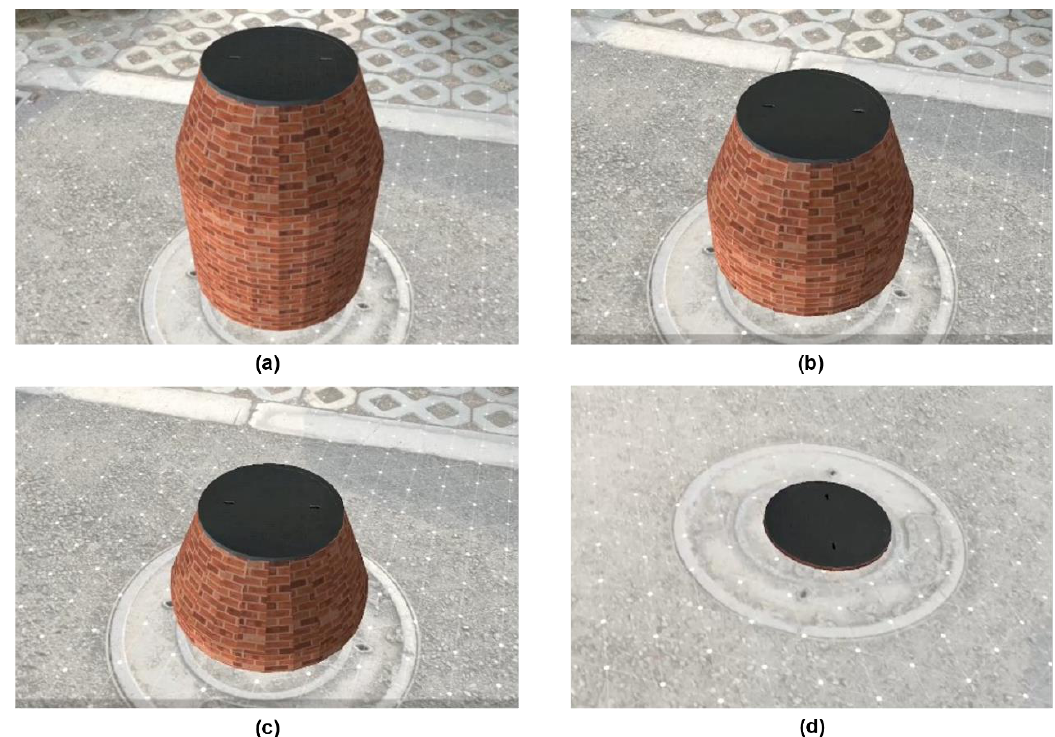
Figure 14. Correct visualization of virtual geographic data based on depth and masking: ( a ) no occlusion; ( b ) minimal occlusion; ( c ) partial occlusion; ( d ) almost all occlusion. occlusion; ( c ) partial occlusion; ( d ) almost all